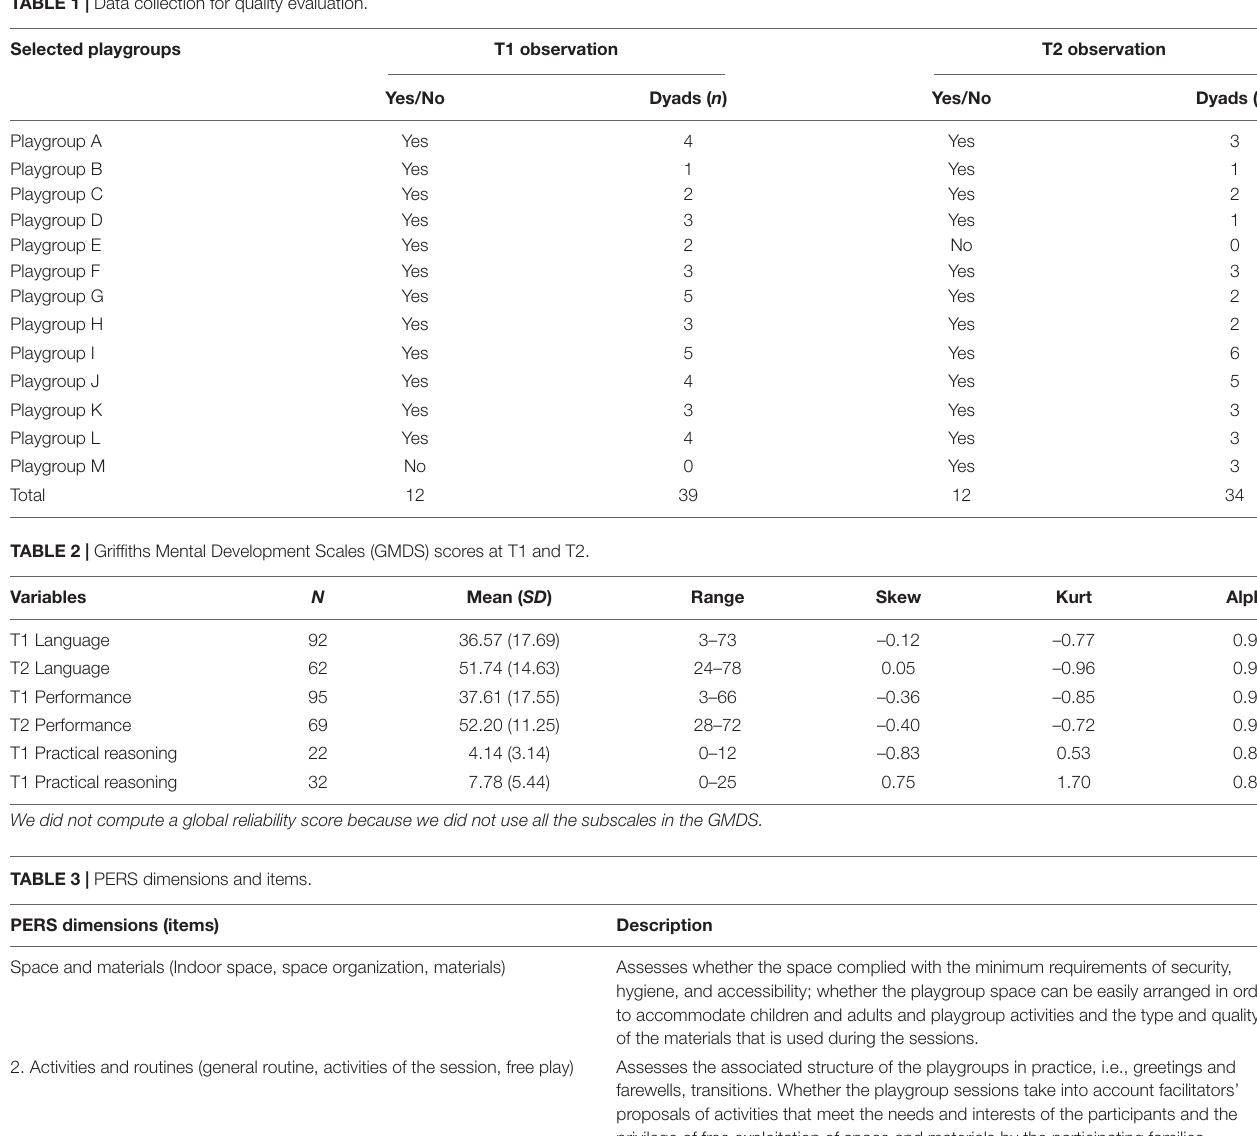
TABLE 1 | Data collection for quality evaluation.